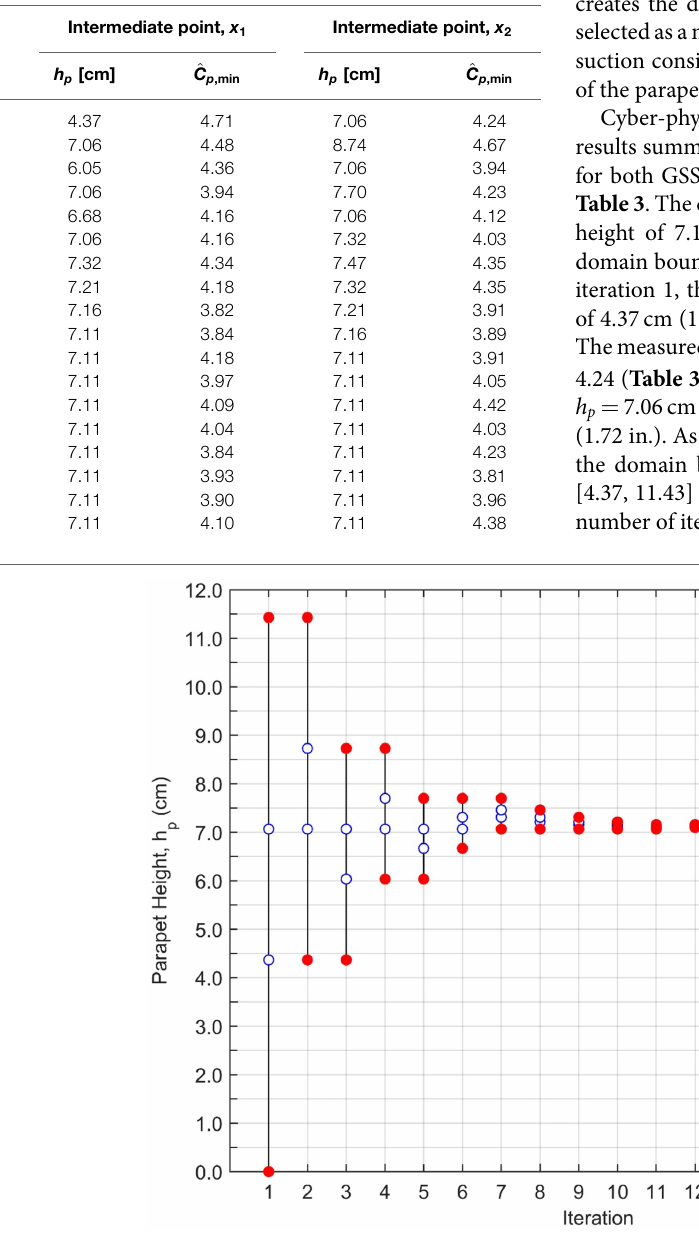
FIGURE 7 | Parapet height iteration history using golden section search (Case